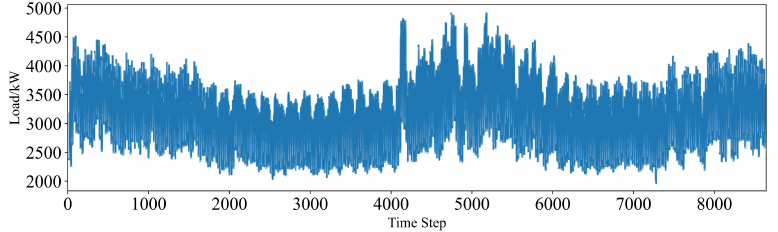
Figure 7. Electricity load in New England during 2014.